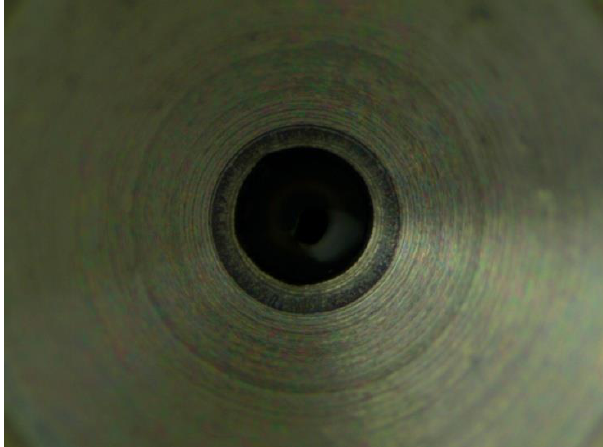
Fig. 5. Valve seat